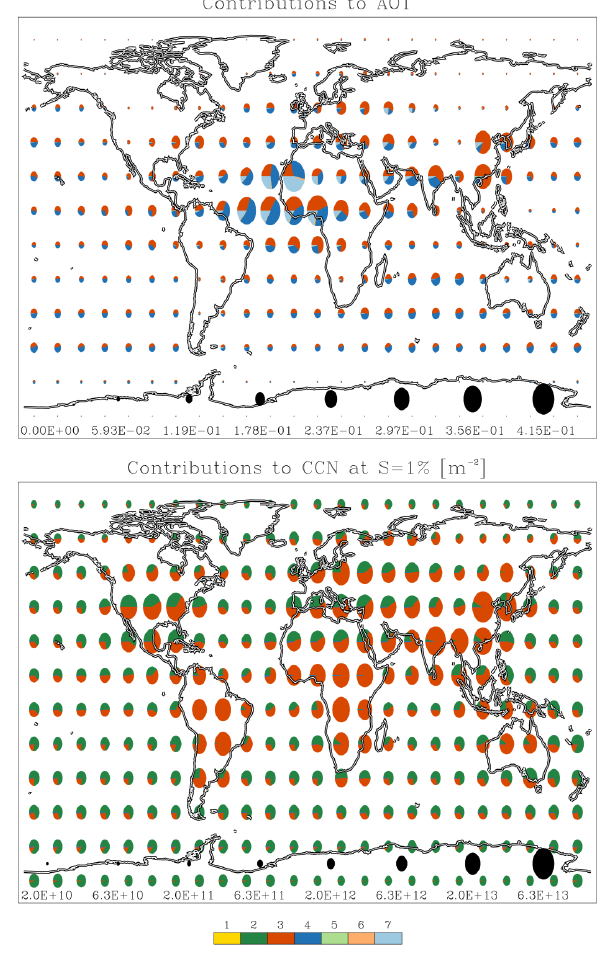
Figure 2. Contributions by different modes to AOT and CCN for the baseline experiment. The pie chart colors show contribution by mode (see legend below lowest panel); the pie chart’s size shows the overall magnitude (legend at the bottom of each panel). From top to bottom: AOT at 550nm (linear scale); column-integrated CCN at S = 1% (logarithmic